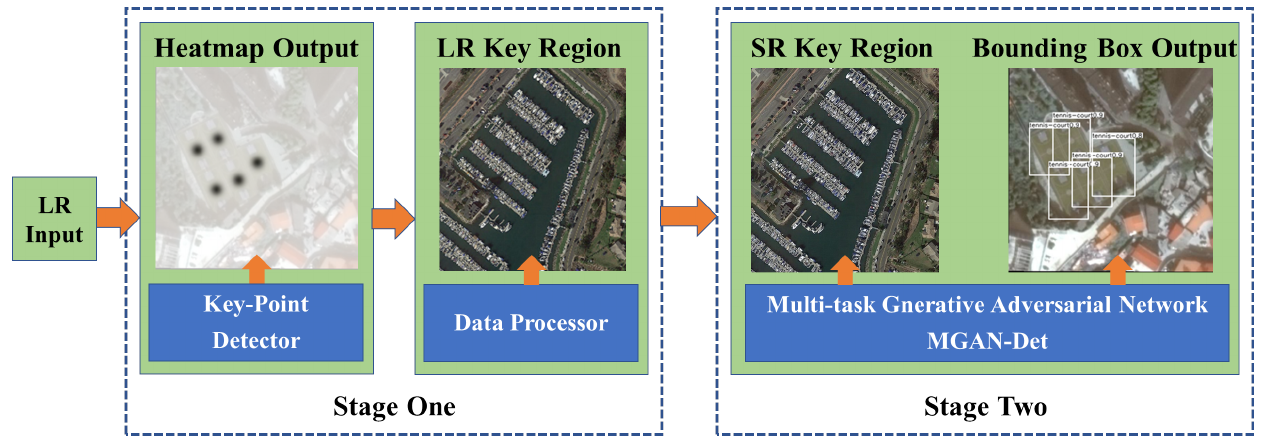
Figure 1. The architecture of HSOD-Net. It has two stages for our hierarchical point-to-region detection strategy, including key-point guided rough object position extraction and multi-task GAN.